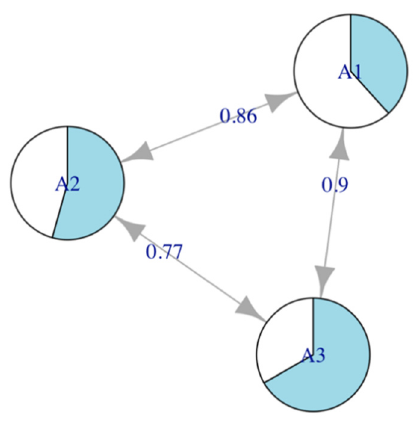
Figure 9. Network plot for attribute correlations and prevalence.